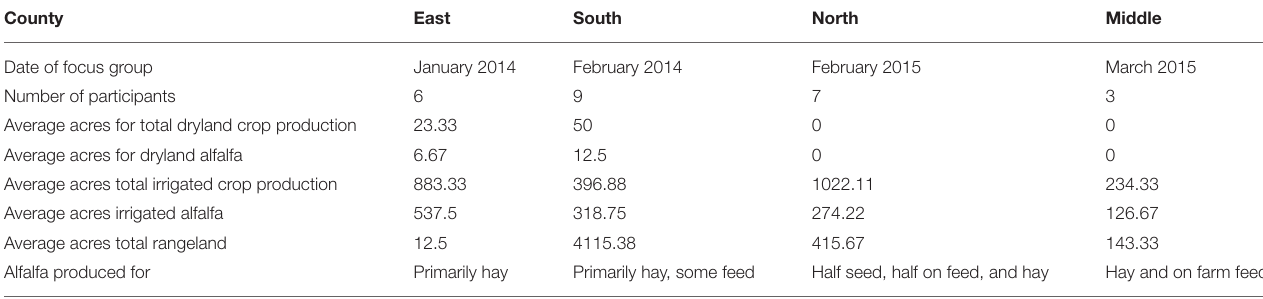
TABLE 1 | Descriptive statistics for focus group